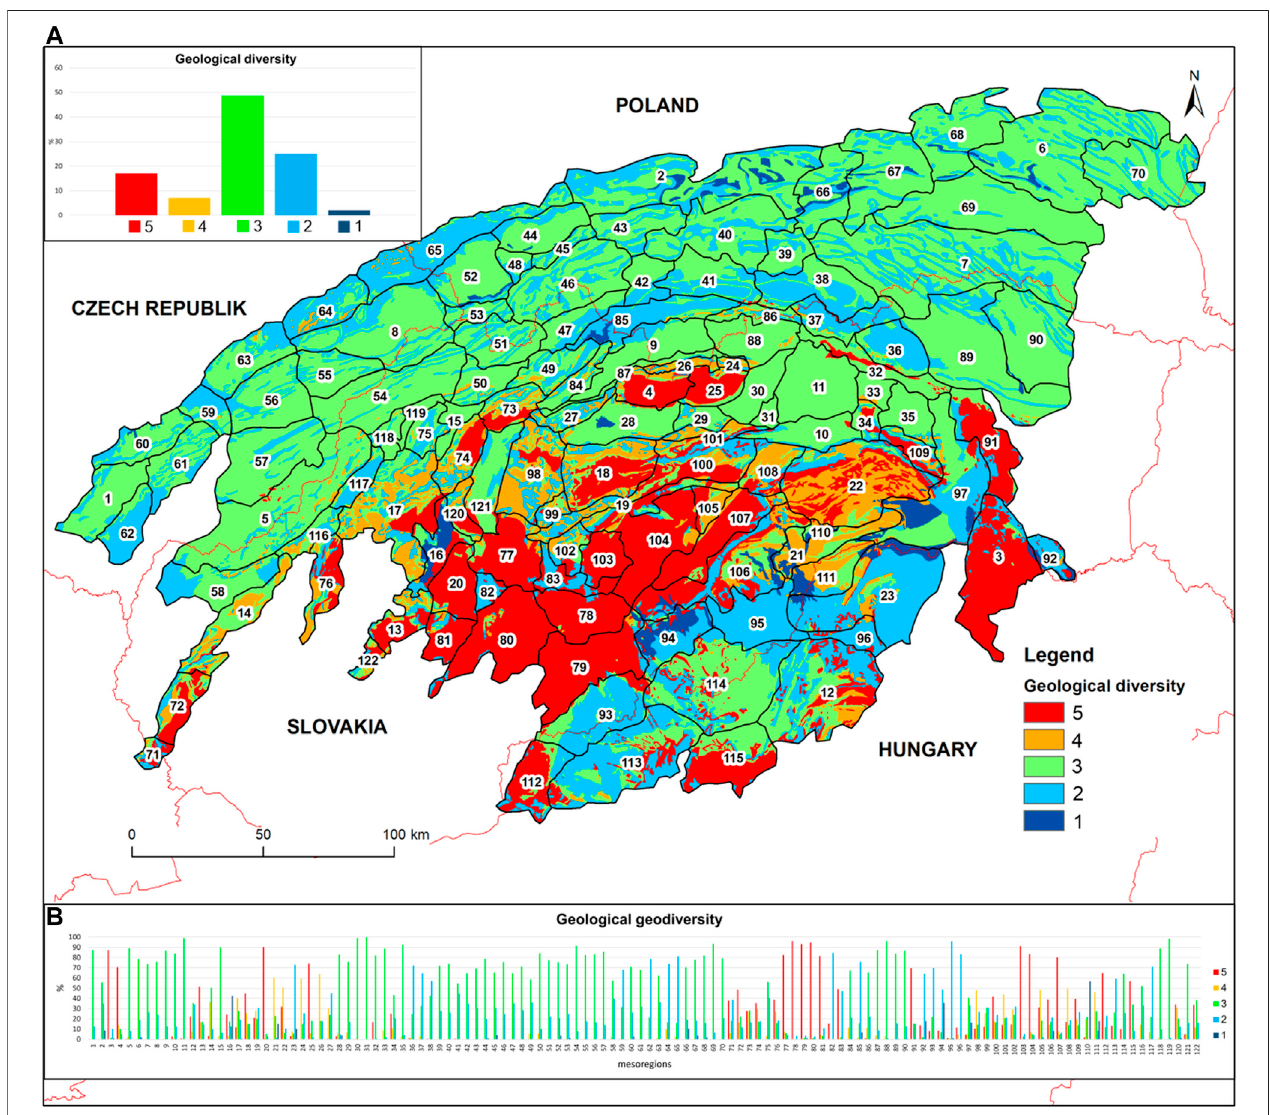
FIGURE 6 | Geological geodiversity map. 1: Quaternary rocks; 2: clay shales, crushers, and claystones; 3: sandstones and fl ysch formations; 4: limestones and dolomites; 5: crystalline, volcanic, and metamorphic rocks. For numbers of mesoregions, see Figure 2 . Source: own research.